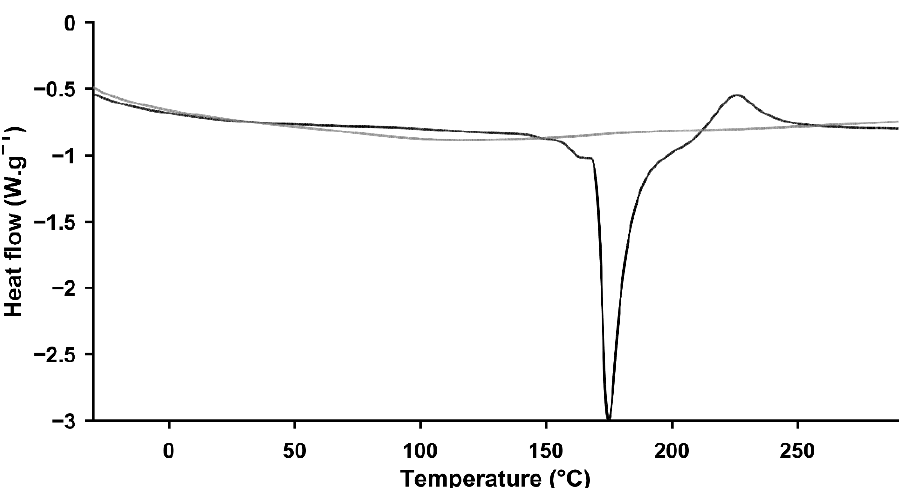
Figure 4. Modulated differential scanning calorimetry (mDSC) thermograms of pectin ‐ (black line) and silica ‐ based aerogels (grey line).